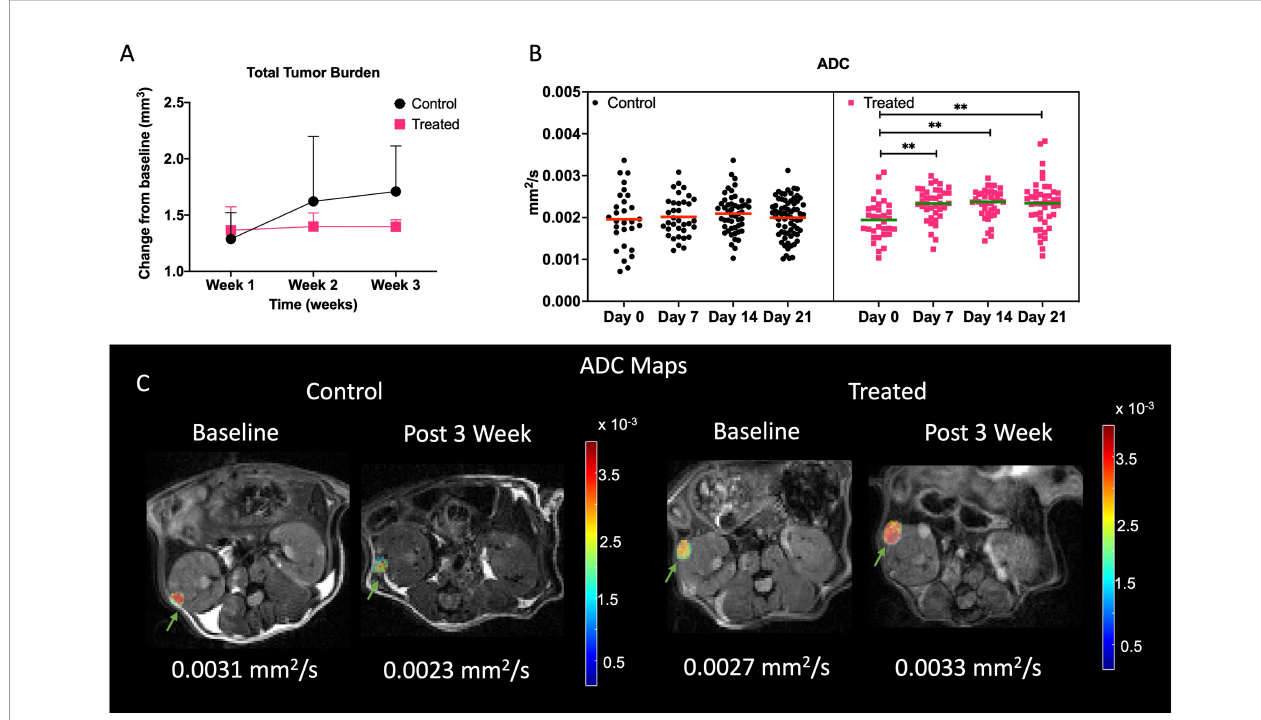
FIGURE 5 | Impact of treatment on physiological properties of lesions. (A) Lesion volume change with respect to baseline in control and treated mice. (B) Mean ADC of all the lesions in control and treated cohort over time. Representative ADC maps overlaid on diffusion weighted imaged at b = 25 s/mm 2 at baseline and week 3 for control and treated tumors (C) . Lesions are indicated with green arrows. ** indicates